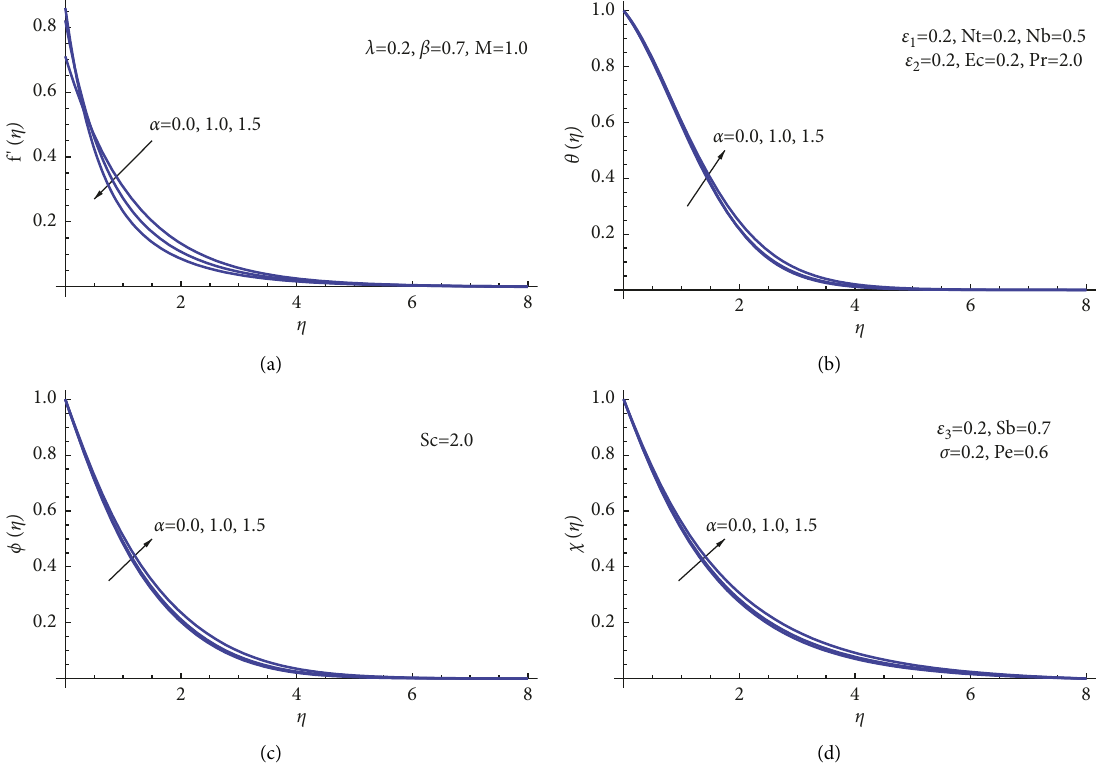
Figure 4: (a) Impact of α on f ′ ( η ) . (b) Impact of α on θ ( η ) . (c) Impact of α on ϕ ( η ) . (d) Impact of α on χ ( η )